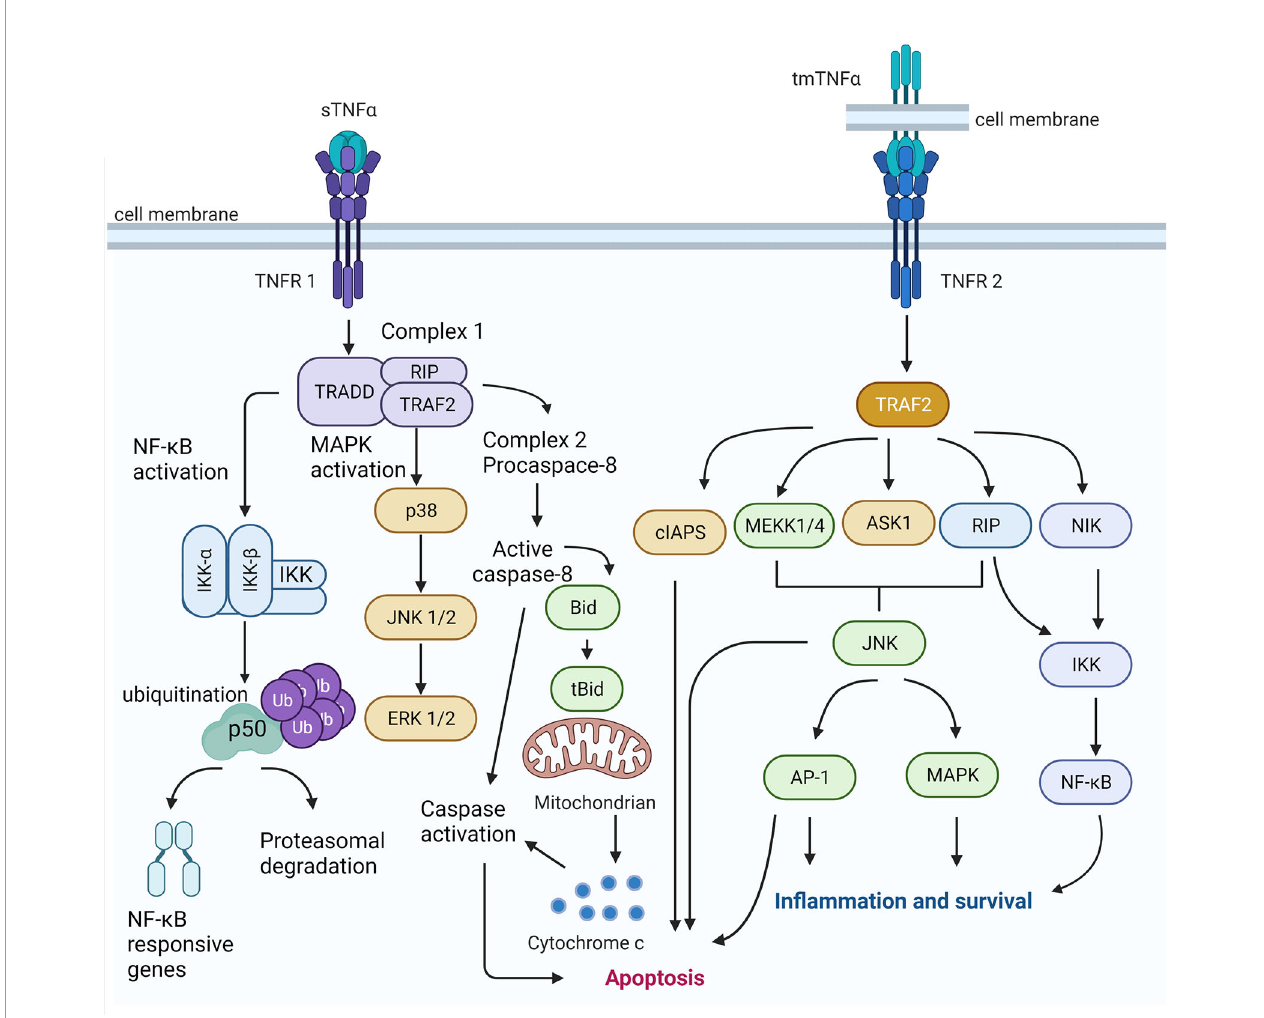
FIGURE 1 | TNFR1 and TNF2 signaling pathways. The sTNF a enhances the TNFR1 induced classical NF-kB signaling and apoptosis. The activation of TNF signaling from complex I result in the activation of the transcription factor of NF-kB-associated responsive genes. It activates different MAPK cascades, which ultimately activates the ERK signaling. On the other hand, TNF-induced signaling can give inhibition of caspase 8, which may trigger an alternative mode of programmed cell death (i.e., necroptosis). The occupancy of TNFR2 by tmTNF leads to the recruitment of TRAF2 and a cellular inhibitor of apoptosis protein-1 (clAP-1) and cellular inhibitor of apoptosis protein-2 (clAP-2). Signaling TRAF2 is also thought to activate a mitogen activated protein kinase kinase kinase (MAPKKK), such as or apoptosis-stimulated kinase 1 (ASK1) or extracellular signal-regulated kinase kinase 1 (MEKK1), in a complex at or near the receptor and Protein kinase RIP, which is the activation of the transcription factor NF-kB is required to the functioning of a third arm of the TNF signaling network. TNFR2 has been suggested to provoke cell proliferation and survival. Created using BioRender